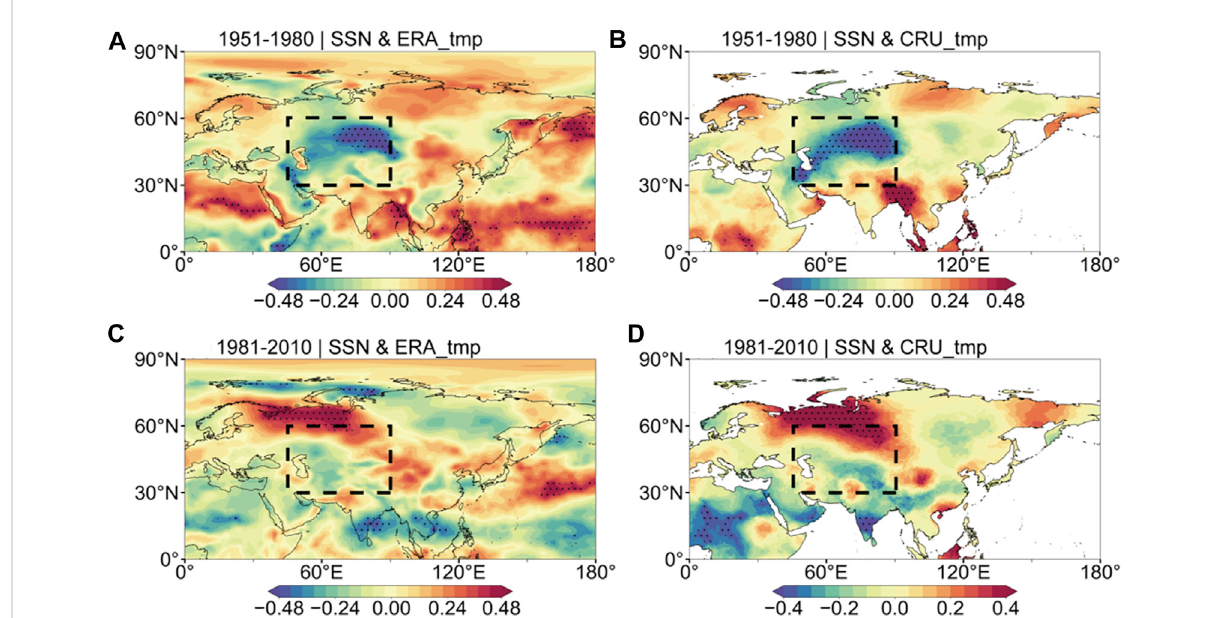
FIGURE 11 CorrelationmapsbetweenSSNandtemperatureduring1951 – 1980(P1)and1981 – 2010(P2).Dottedregionsareatabove95%con fi dencelevel. Central Asia (30 ° N – 60 ° N and 50 ° E – 90 ° E) is marked by the black dashed frame. (A) 1951 – 1980 SSN and ERA_tmp. (B) 1951 – 1980 SSN and CRU_ tmp. (C) 1981 – 2010 SSN and ERA_tmp. (D) 1981 – 2010 SSN and